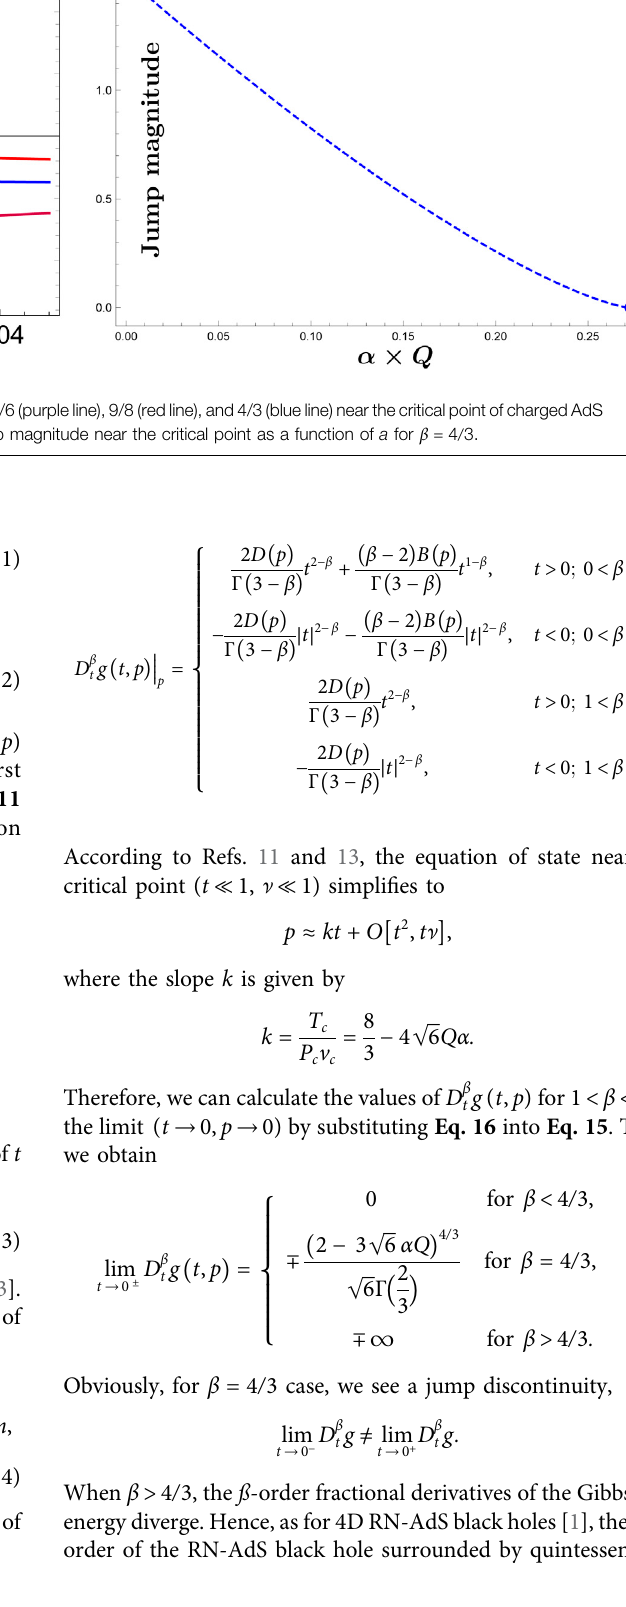
Frontiers in Physics |